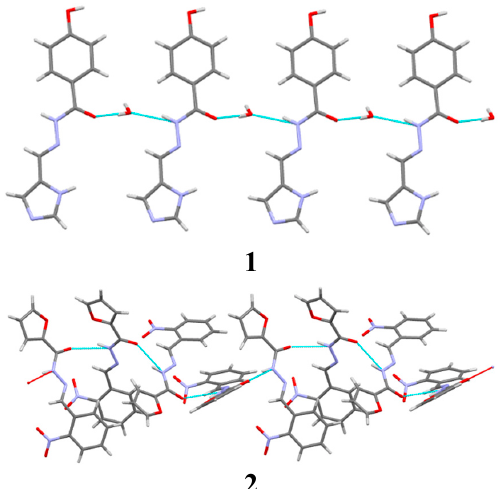
Figure 3. 1D-chained structure of Compounds 1 and 2 via hydrogen bonds.